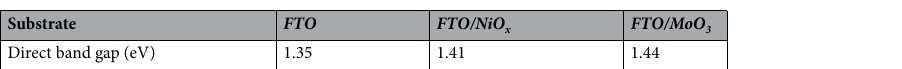
Table 3. The direct band gap (eV) of CISe films deposited on different substrates was calculated by UV-Vis analysis.